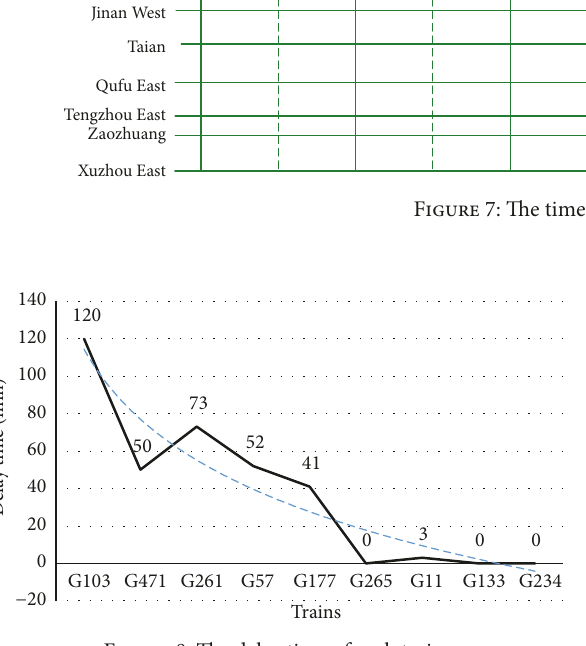
Figure 8: The delay time of each